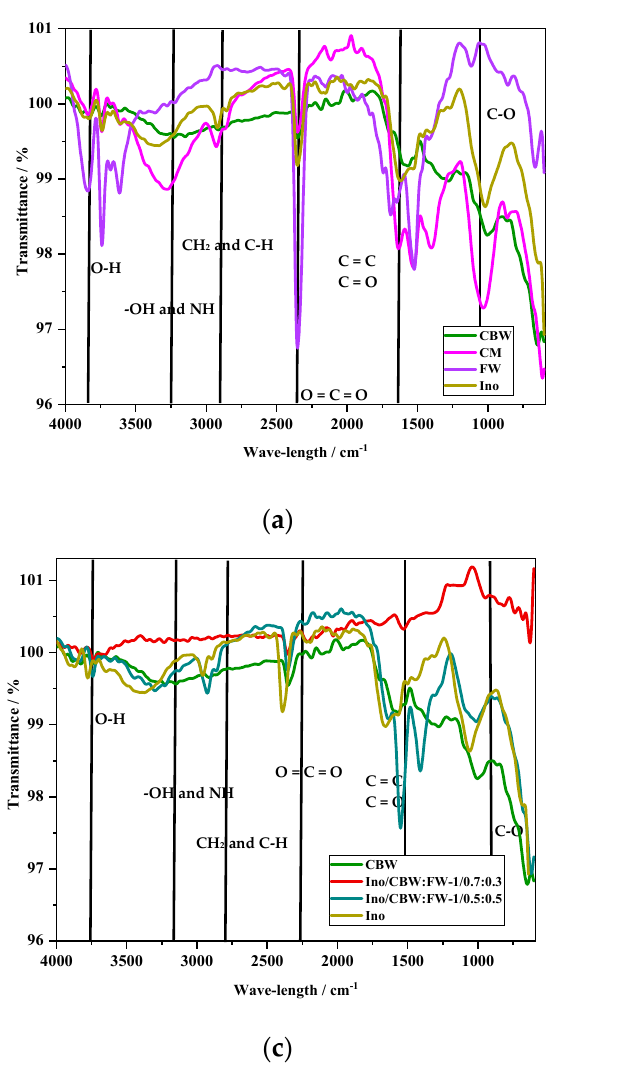
Figure 5. FTIR spectroscopy analysis. ( a ) Cork boiling wastewater (CBW), cow manure (CM), food waste (FW), and inoculum (Ino); ( b ) AD of different ratios of mixture of inoculum and cork boiling wastewater (Ino/CBW); ( c ) anaerobic digestion of different ratios of mixture of inoculum, cork boiling wastewater, and food waste (Ino/CBW:FW); ( d ) anaerobic digestion of different ratios of mixture of inoculum, cork boiling wastewater, and cow manure (Ino/CBW:CM).